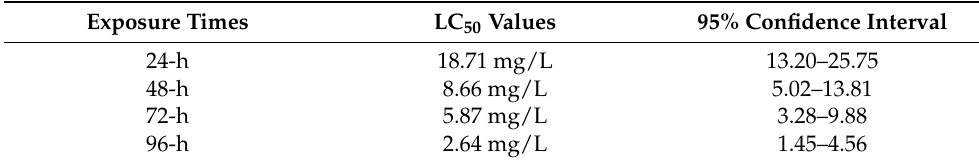
Table 1. The LC 50 values of fipronil and 95% confidence